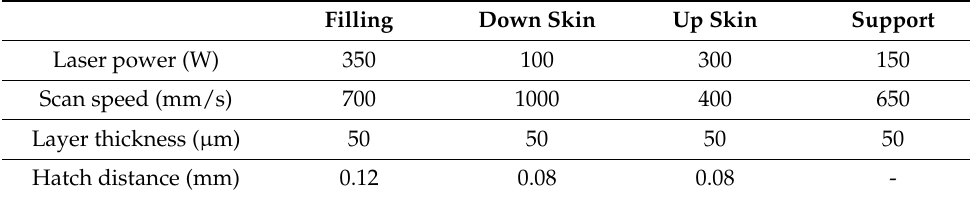
Table 2. Laser parameters used for the fabrication of different areas within the specimen.